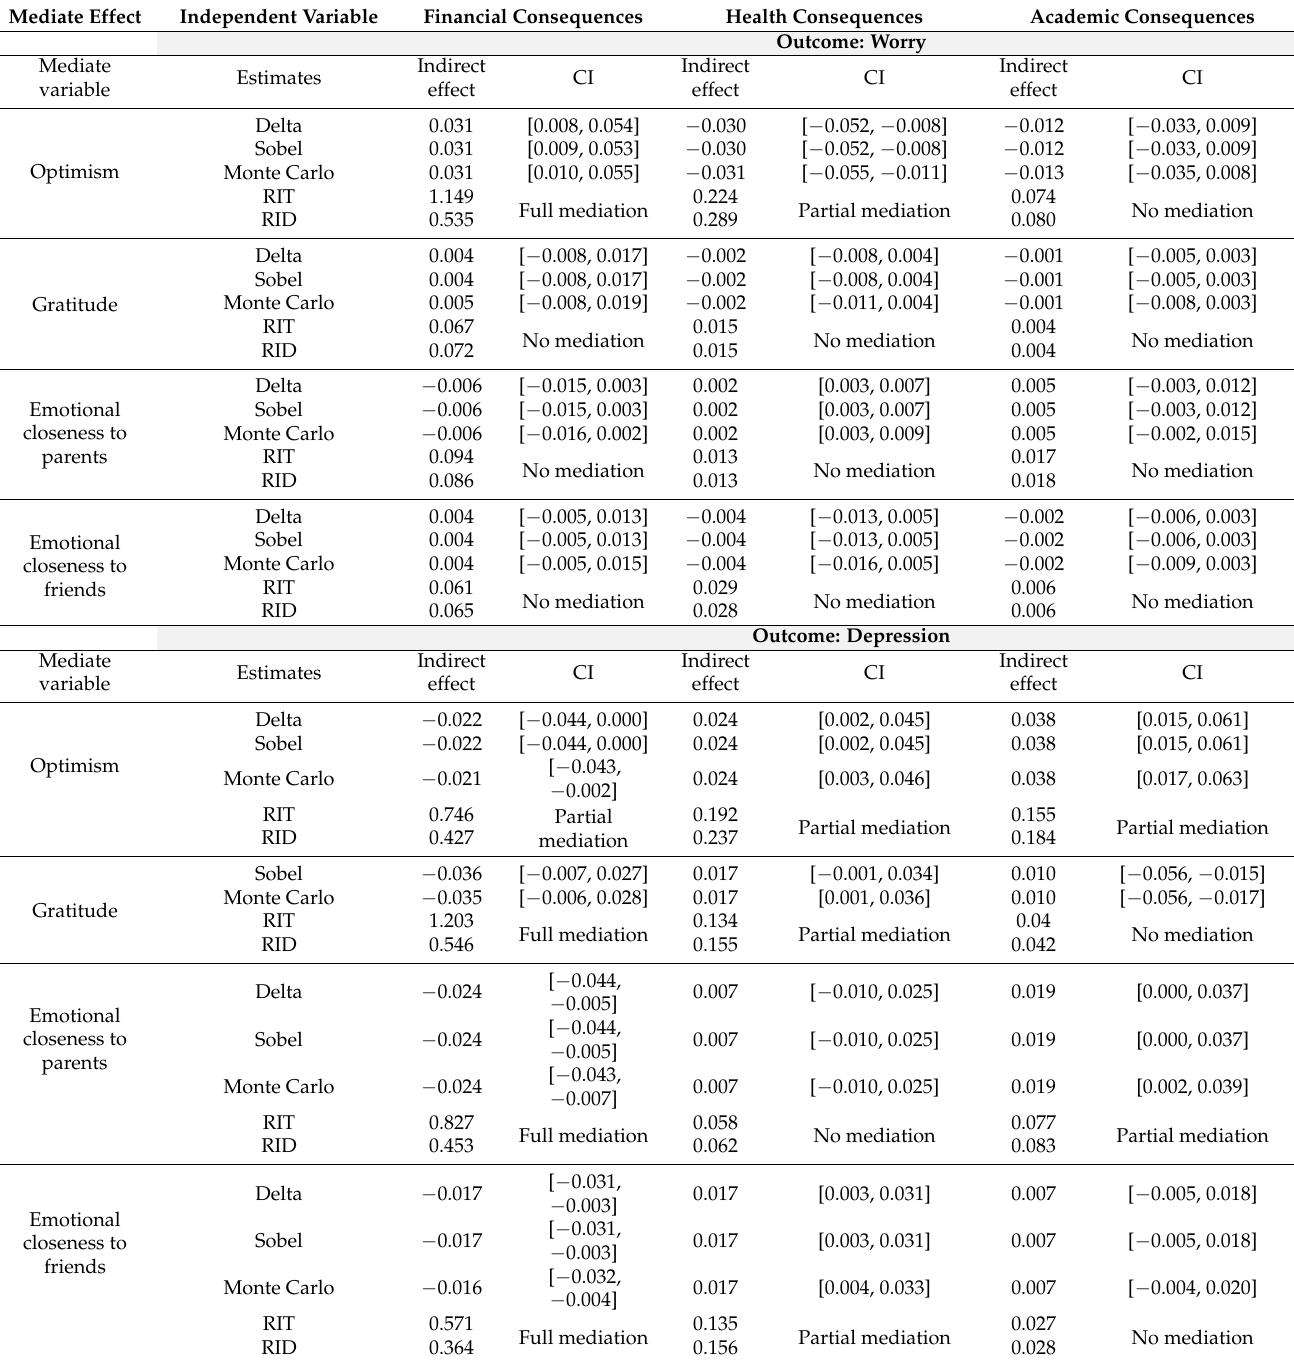
Table 4. Mediate effect of coping strategic on worry and